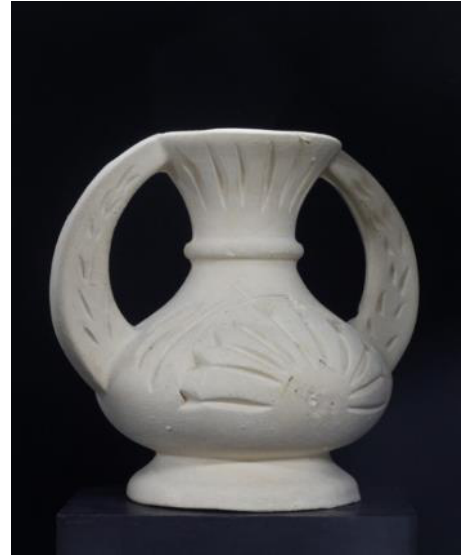
Figure 1. The photograph of object Vase. A diode-pumped solid-state laser was used as a radiation source (DPSS-laser) with wavelength λ = 640 nm. Monochromatic high- resolution photographic plates for holography (PPH-03M plates 102×127 mm manufactured by LLC TD “Slavich” (PPH-03M, n.d.)) were used as a photosensitive material. PPH-03M is a thick halide-silver composition designed for recording counter directional reflective type of holograms sensitized to radiation in the red region of the visible frequency range of the electromagnetic spectrum.